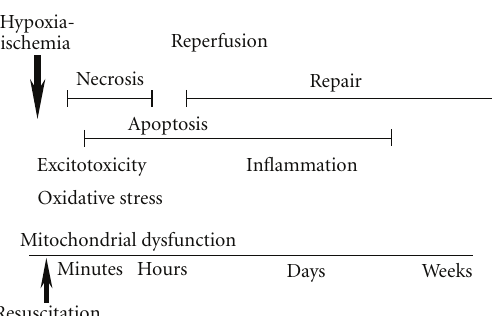
Figure 1: The evolution and major mechanisms of hypoxic- ischemic brain injury. Arrows indicate HI insult and resuscitation (reperfusion), two fundamental events that cause cerebral damage. Di ff erent mechanisms may take a lead in the evolution of brain injury: initiated by the bioenergetics mitochondrial dysfunction, cellular injury is driven by excitotoxicity and oxidative stress, followed by the neuroinflammation. The paper is focused on the proximal to the index event mechanism, an oxidative stress and the role of mitochondrial generation of ROS (see text), modified from